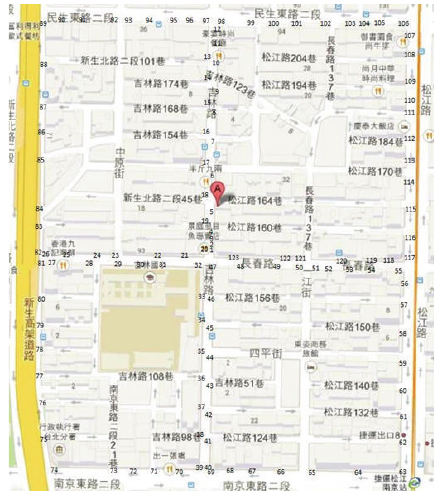
Figure 8: An urban area of Taipei City with 123 test sites numbered from 1 to 123. The LTE base station is located at the center of the urban area marked with a red sign